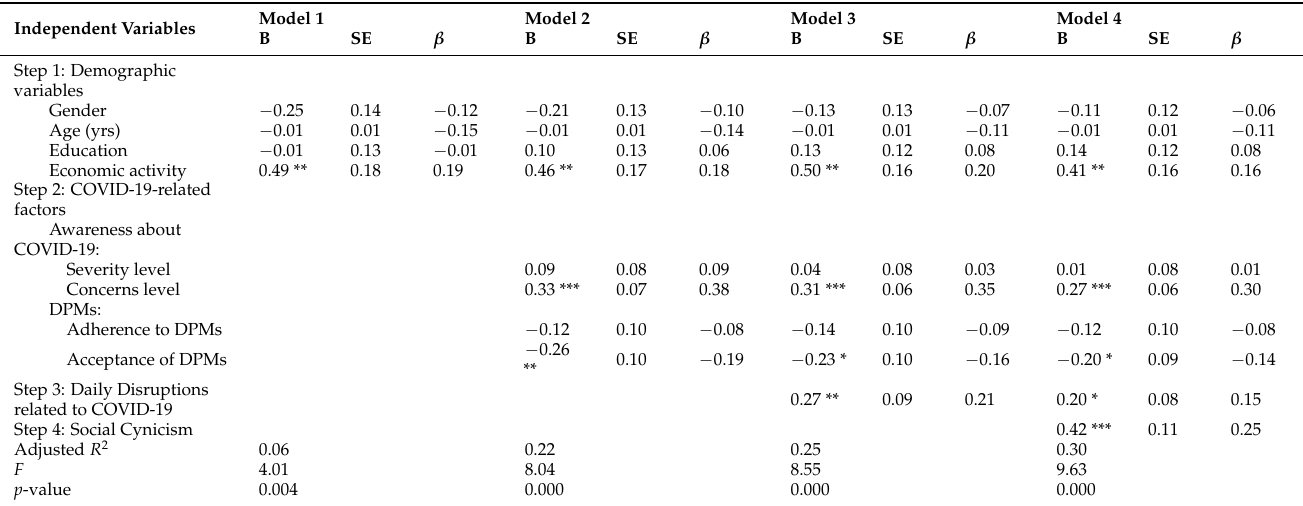
Table 5. Hierarchical Regression Analysis for Coping